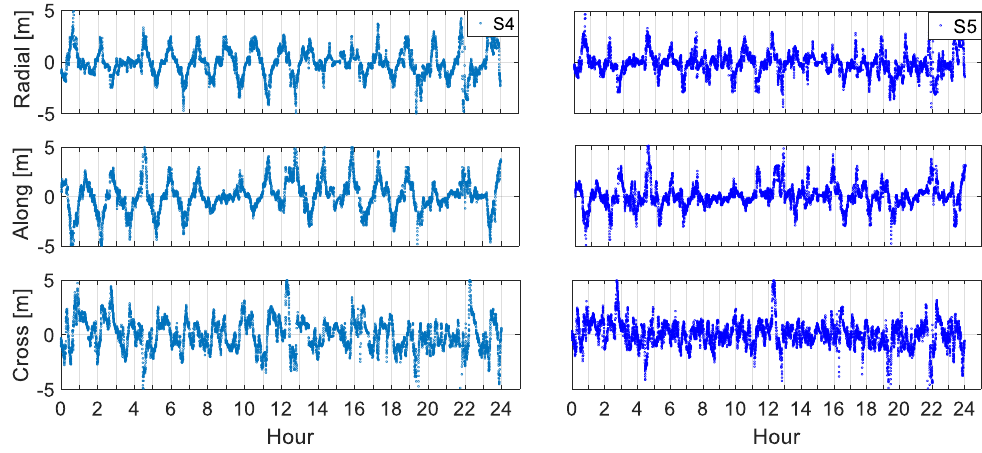
Figure 10. GRACE-A real-time POD results of Schemes 4 ( left ) and 5 ( right ). Table 5. Statistical results of Swarm-A and GRACE-A orbit solutions from different schemes (unit: m). Scheme S1 S2 Radial Swarm-A Radial GRACE-A